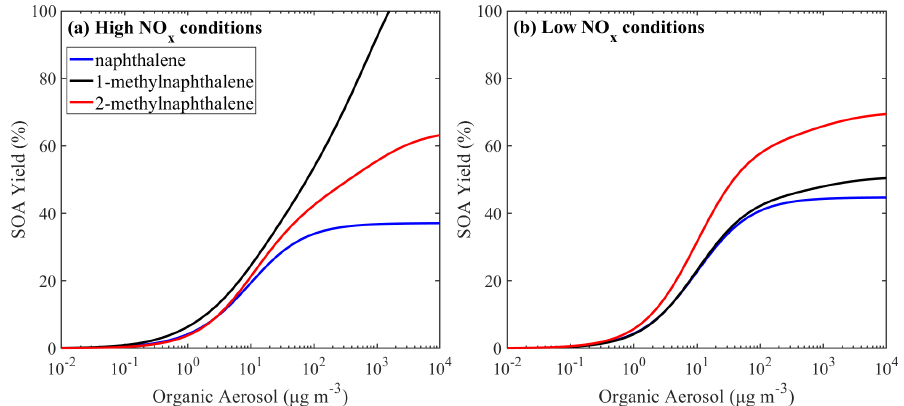
Figure 9. Estimated SOA yields of naphthalene, 1-methylnaphthalene and 2-methylnaphthalene under (a) high-NO x and (b) low-NO x conditions. The curves are generated using the estimated parameters of Table